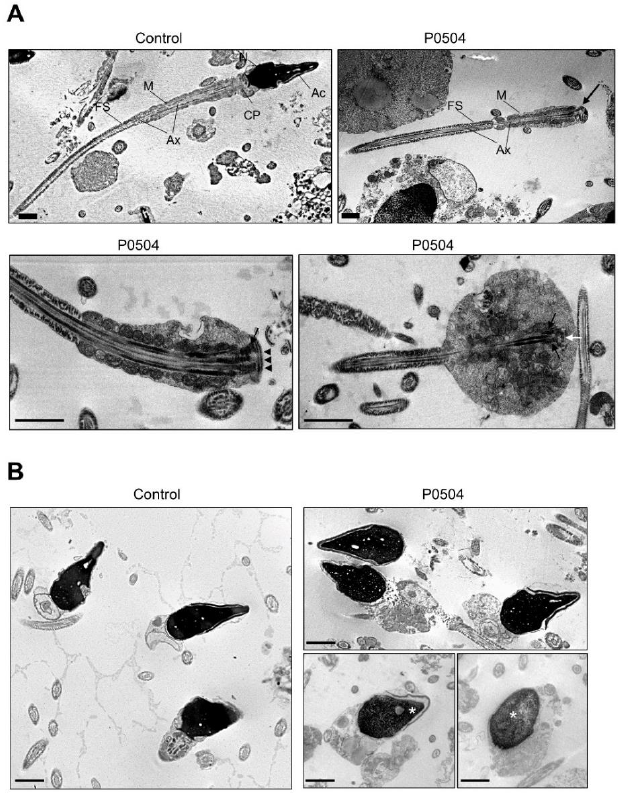
Figure 3. Sperm ultrastructure analysis by transmission electron microscopy (TEM). TEM analysis of semen samples from a control individual and from individual P0504. ( A ) Longitudinal sections of sperm flagella showing an overall regular organization of the midpiece and principal piece in the sample from individual P0504, although some flagella were identified with cytoplasmic remnants and an irregular mitochondrial sheath. The head–tail junction was also clearly distinguishable, as were the centriole (white arrow) and the striated columns (black arrow); the basal plate was also visible (black arrowheads). Ac: acrosome; N: nucleus; MS: mitochondrial sheath; Ax: axoneme; FS: fibrous sheath. Scale bars represent 1 µ m. ( B ) Analysis of isolated heads in the semen sample from individual P0504 showing normal acrosomal structure but altered chromatin condensation (white asterisk). Scale bars represent 1 µ